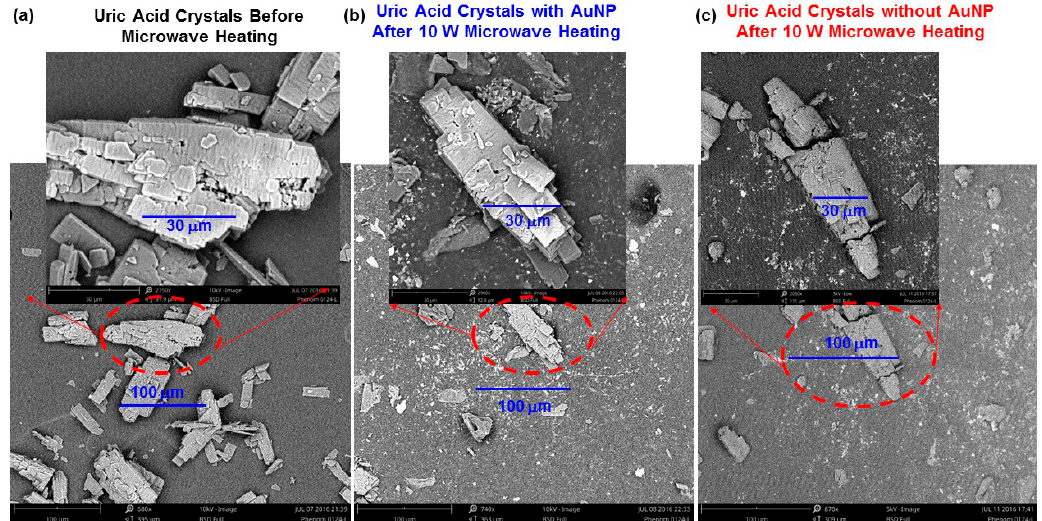
Figure 2. Scanning electron microscope (SEM) images of uric acid crystals (0.2 mg/mL) ( a ) before and ( b ) after microwave heating for 60 s in the presence of gold nanoparticles (i.e., the Metal-Assisted and Microwave-Accelerated Evaporative Decrystallization (MAMAD) technique) and ( c ) after microwave heating in the absence of gold nanoparticles (a control experiment) at 10 W. Scale bars are 100 μ m (large image) and 30 μ m (small image).